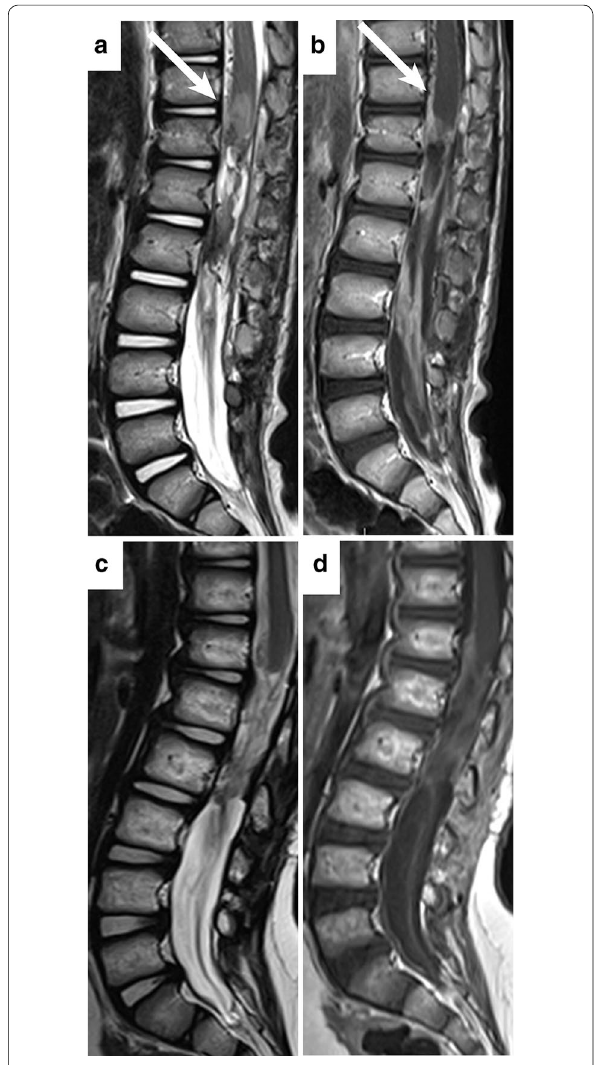
Fig. 2 Postoperative MRI of the boy with spinal GBM of the conus medullaris. Postoperative MRI shows a subtotal resection of the primary lesion and leptomeningeal involvement at the level of the conus medullaris and cauda equine ( arrows ) ( a ); after Gd injection, there is no contrast enhancement ( arrows ) ( b ). Two years after sur‑ gery, MRI shows the absence of relapses ( c ) and stable persistence of the previously documented enhancement along the right anterolat‑ eral conus medullaris (level D10‑D12) and along the cauda equina ( d